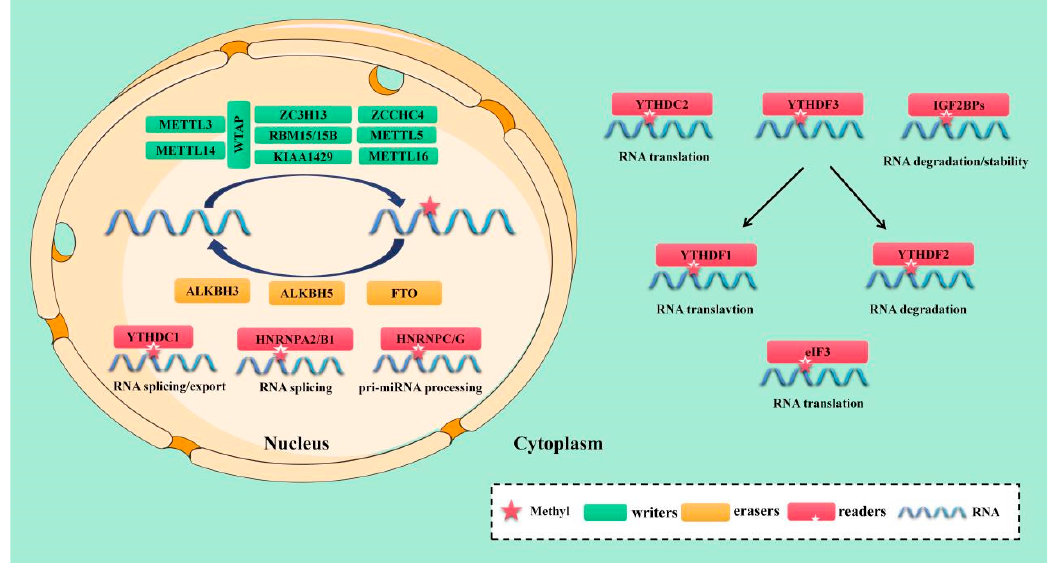
Figure 1. The molecular mechanism of m6A mutation. m6A is installed by “writers” (METTL3/5/14/16, WTAP, RBM15/15B, KIAA1429, ZC3H13 and ZCCHC4,), removed by “eras- ers”(FTO, ALKBH5, and ALKBH3, termed “erasers”), and recognized by “readers”(YTHDC1/2, YTHDF1/2/3, IGF2BP1/2/3, HNRNPA2/B1, HNRNPC/G, and eIF3, termed “readers”. Methyltransferase-like 3 ( METTL3 ) is an S-adenosyl methyl ( SAM ) binding